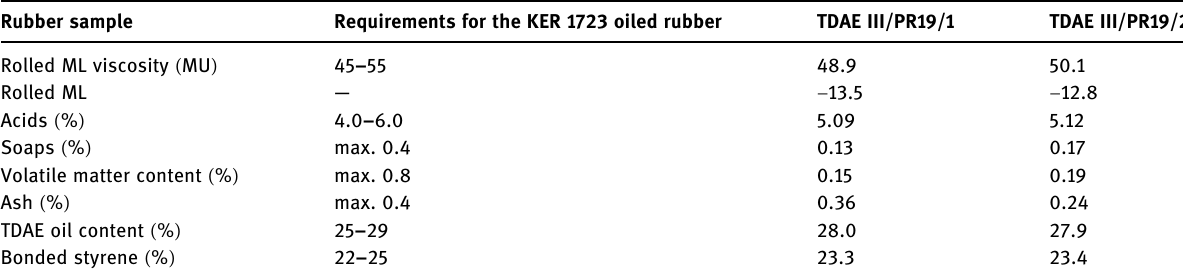
Table 8: Results of physiochemical analysis of the oiled rubber KER 1723 based on TDAEIII/PR19 Rubber sample